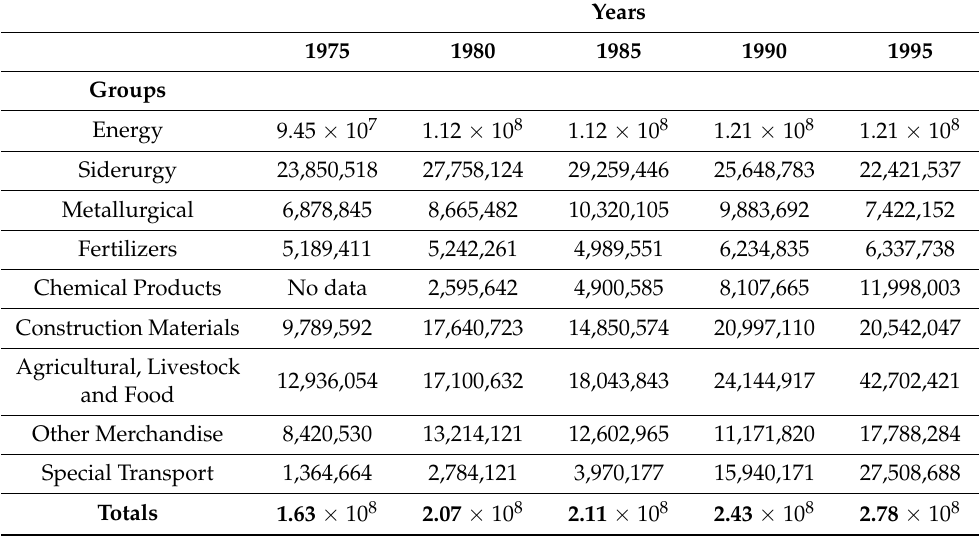
Table 2. Maritime traffic. Volume of goods by types (millions of